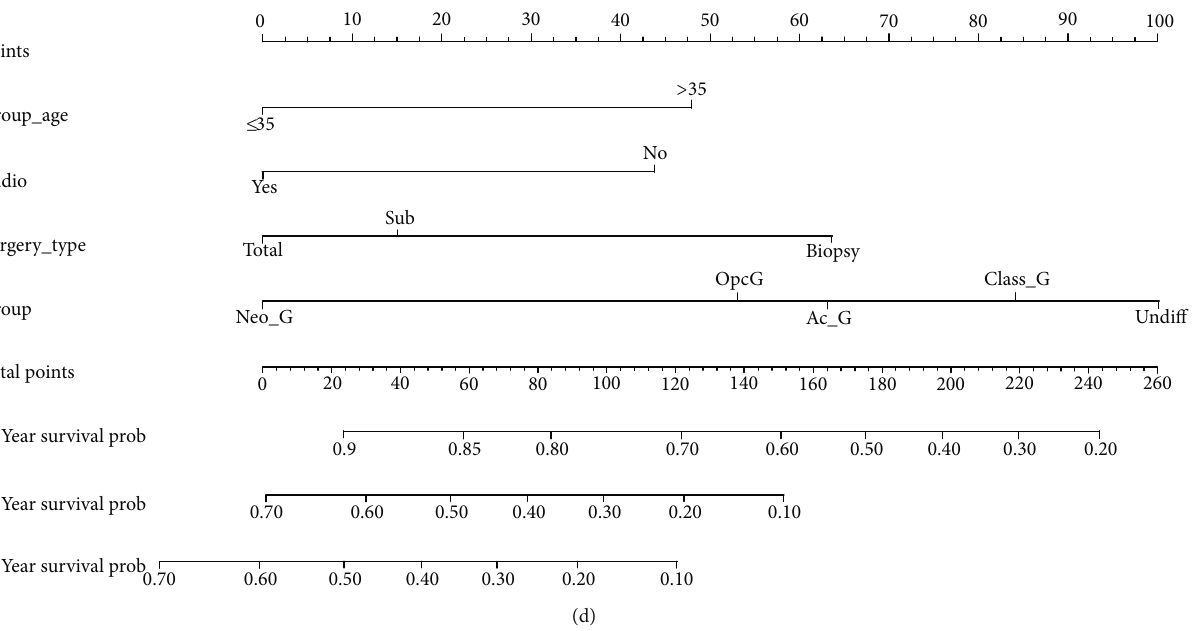
Figure 6: Group classi fi cation of GBM samples based on IHC staining. (a) IHC staining of sixteen gene makers selected from Ac-G/Class- G/Neo-G/Opc-G/Undi ff -G clusters. (b) Heatmap showing the expressions of the selected ten gene markers in each GBM sample. (c) The Kaplan-Meier curves of GBM patients for the fi ve groups. (d) Nomogram predicting patients ’ 1-, 3-, and 5-year overall